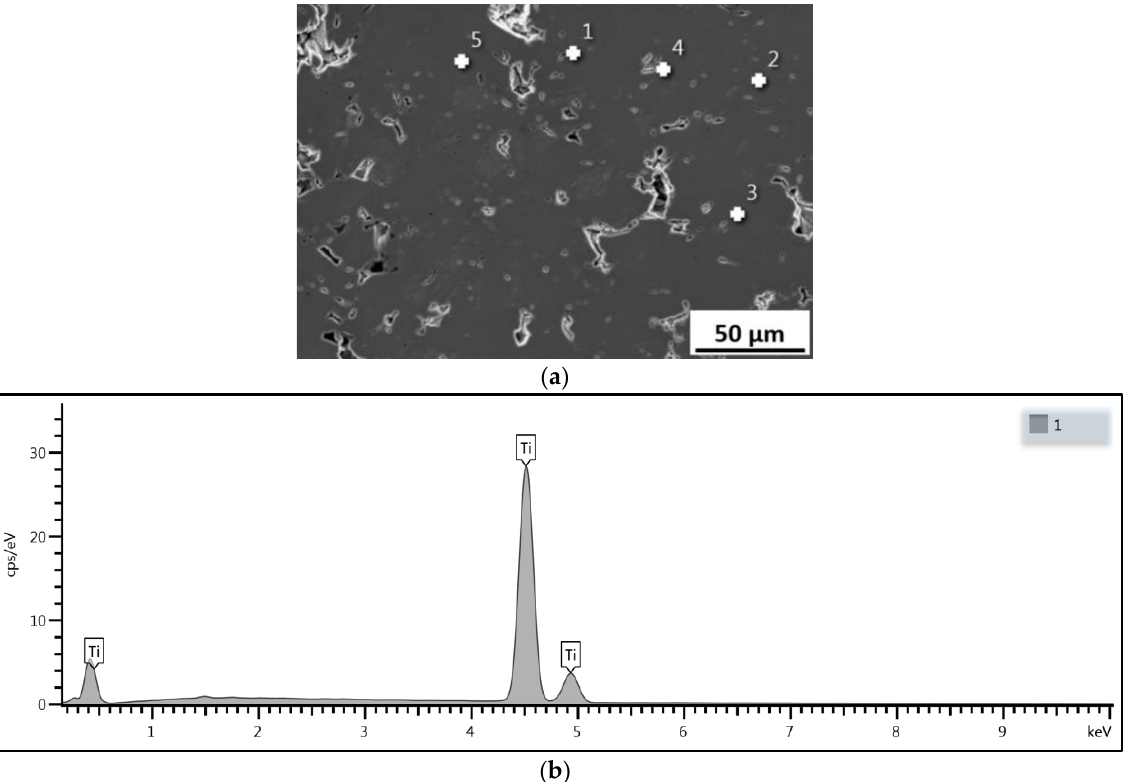
Figure 10. ( a ) Cross-section of a Ti coating sprayed at 100 mm with marked points (1-5) of the EDX analysis (white crosses), ( b ) EDX analysis for point 1.